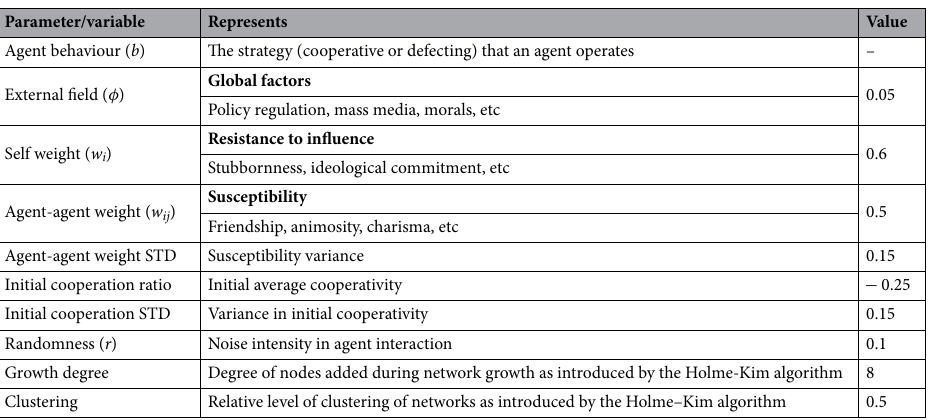
Table 1. Summarizing all model parameters and variables to provide an overview of the model’s components. Here the reference value of each parameter is given, which is used throughout this paper unless otherwise explicitly